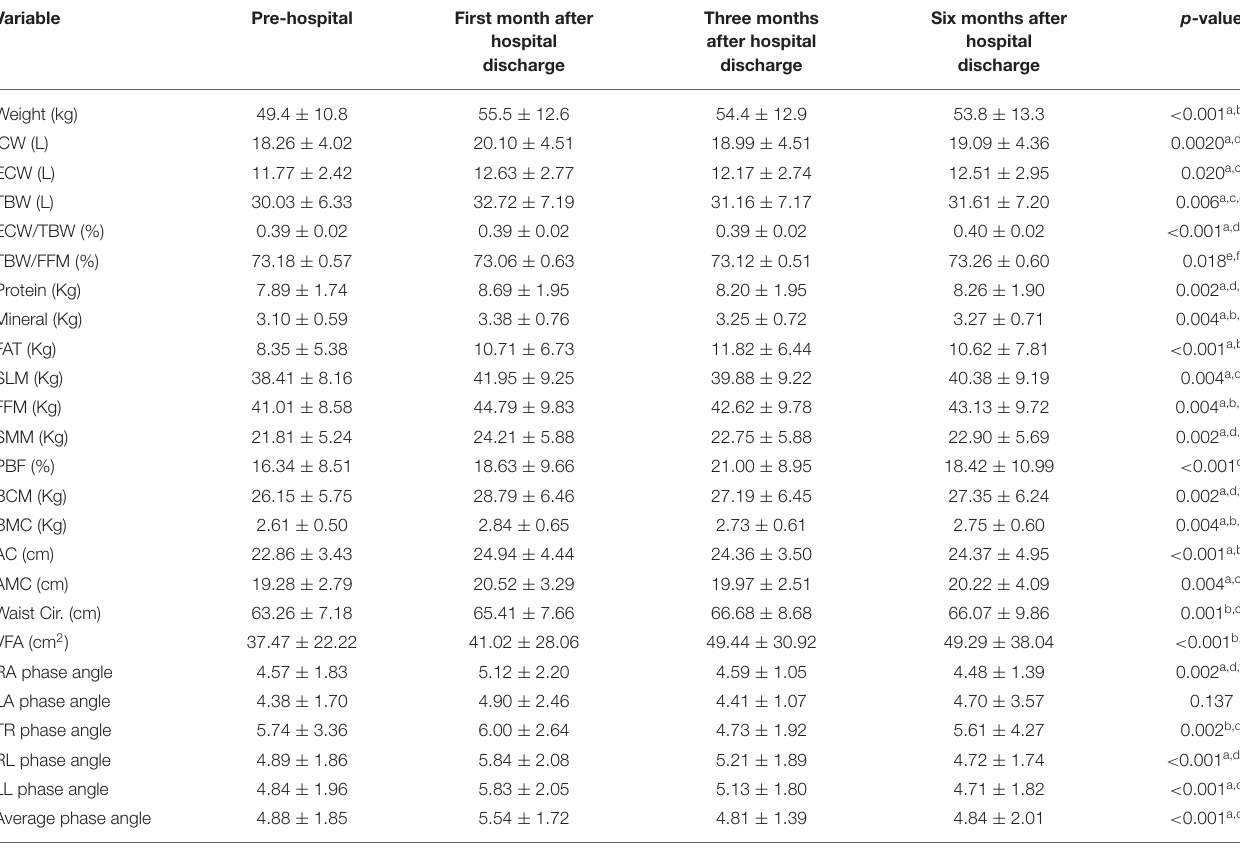
TABLE 3 | Body weight, body composition, and phase angle change.